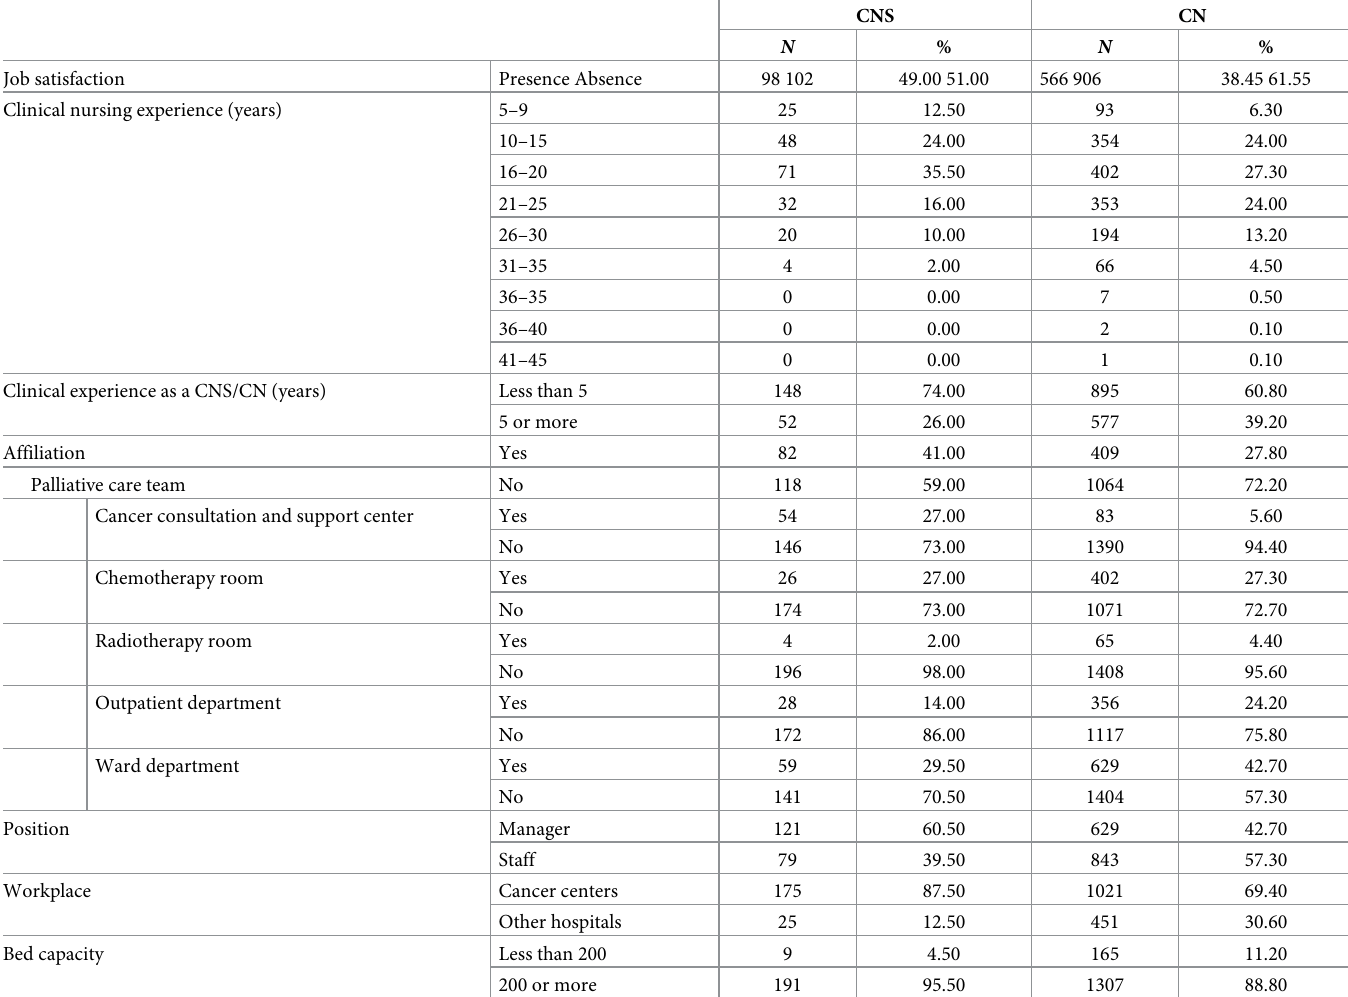
Table 2. Demographic